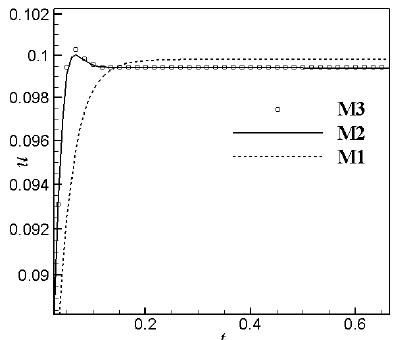
Figure 7. Mesh dependence of the velocity components through the horizontal at Wi = 1.0 using mesh of M1, M2, and M3.